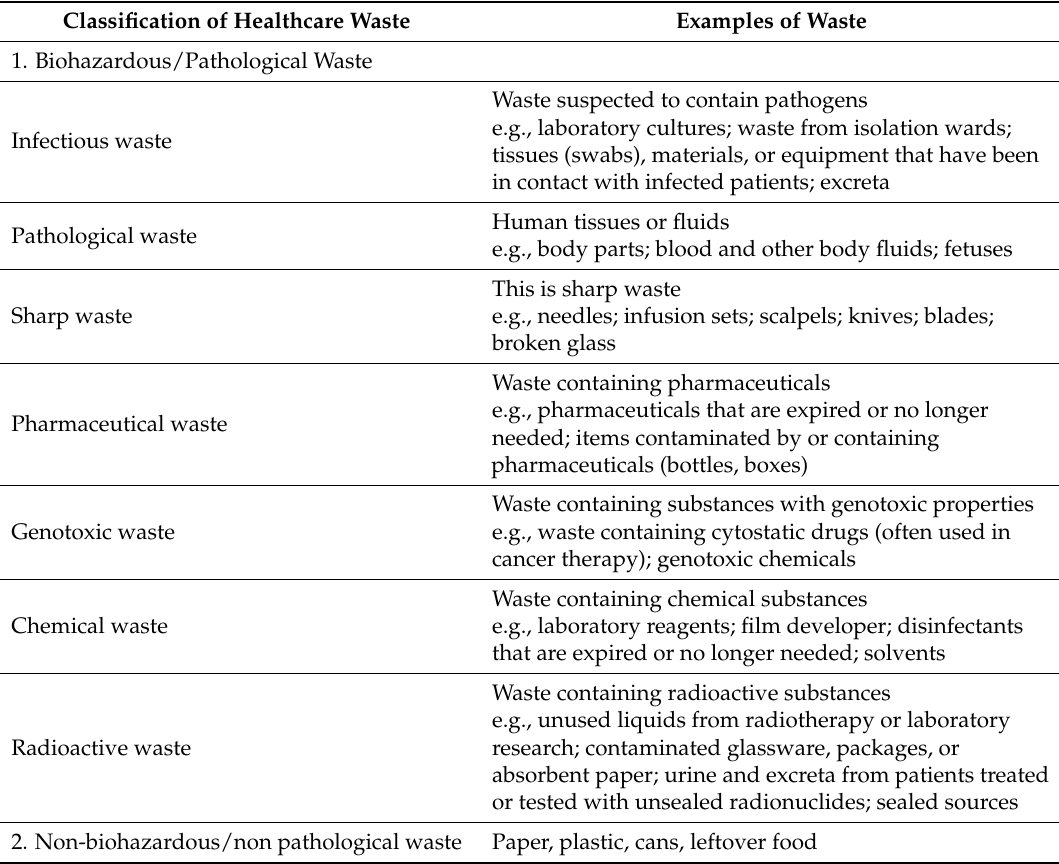
Table 4. Despite using letters of the alphabet to categorize HCW, the description of the HCW as well as the examples that are provided under each category align with those provided by the WHO manual. Table 3. Classification of healthcare waste by low and middle-income countries.